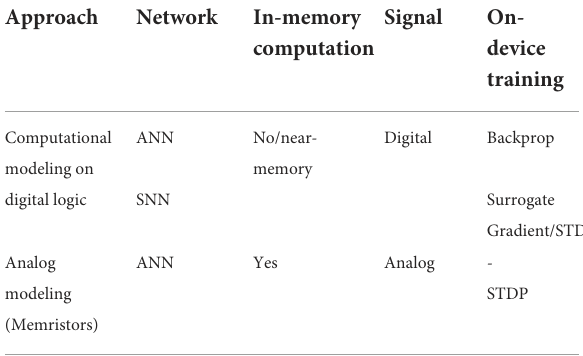
TABLE 1 A comparison of neuromorphic approaches to synapses modeling.